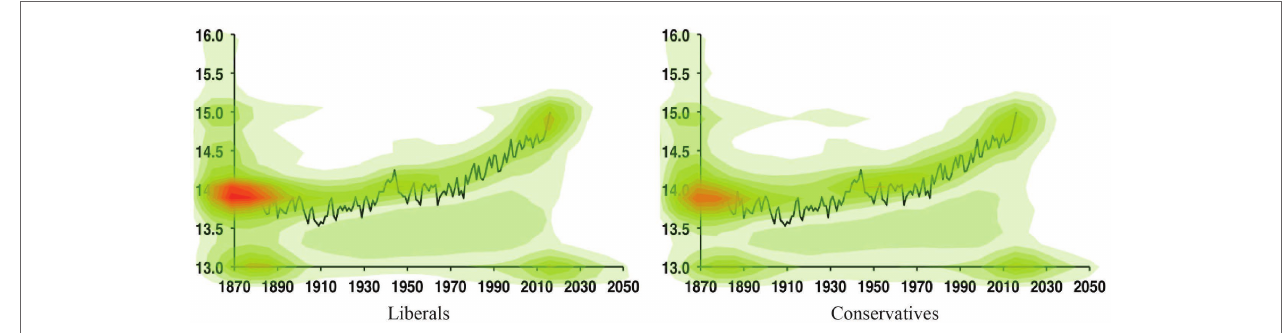
FIGURE 5 | A heatmap showing the distribution of the average density of mouse location on the graph for liberals (left, N = 47) and for conservatives (right, N = 29) in the temperature condition. Participants whose ratings on the political orientation scale were below 0 were grouped as liberals and whose ratings on the political orientation scale were above 0 were grouped as conservatives. Warmer colors represent higher average density of mouse location.